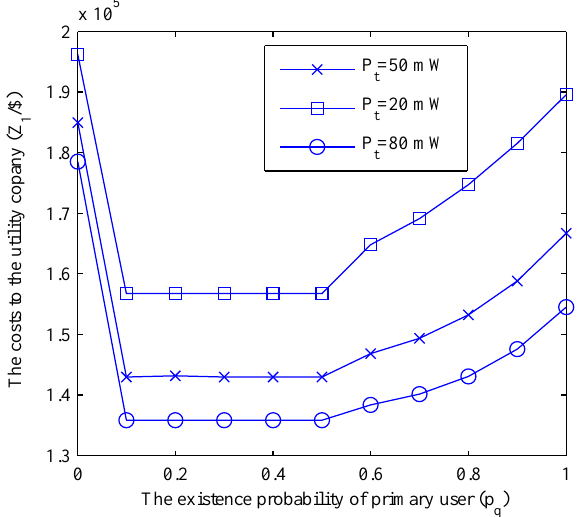
Figure 8. The costs to utility company under different P t .